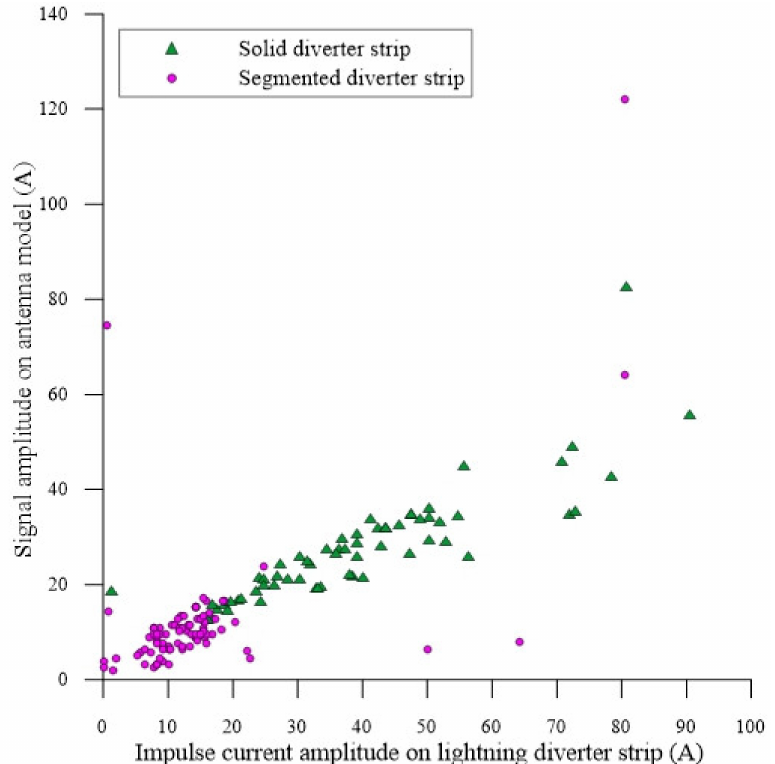
Figure 14. Dependence of the amplitude of the reverse current at the antenna on the amplitude of the current impulse at the lightning diverter (types of impulses 1–3).